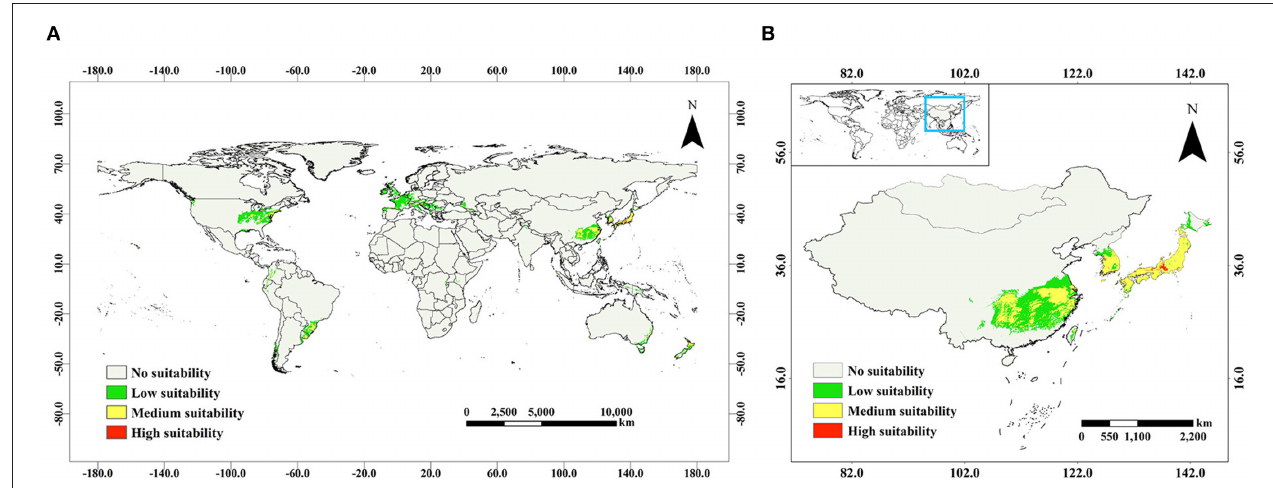
FIGURE 4 | Prediction of suitable distribution regions of A. quinata in the current climate scenario. (A) Distribution of A. quinata in the world. (B) Distribution of A. quinata in East